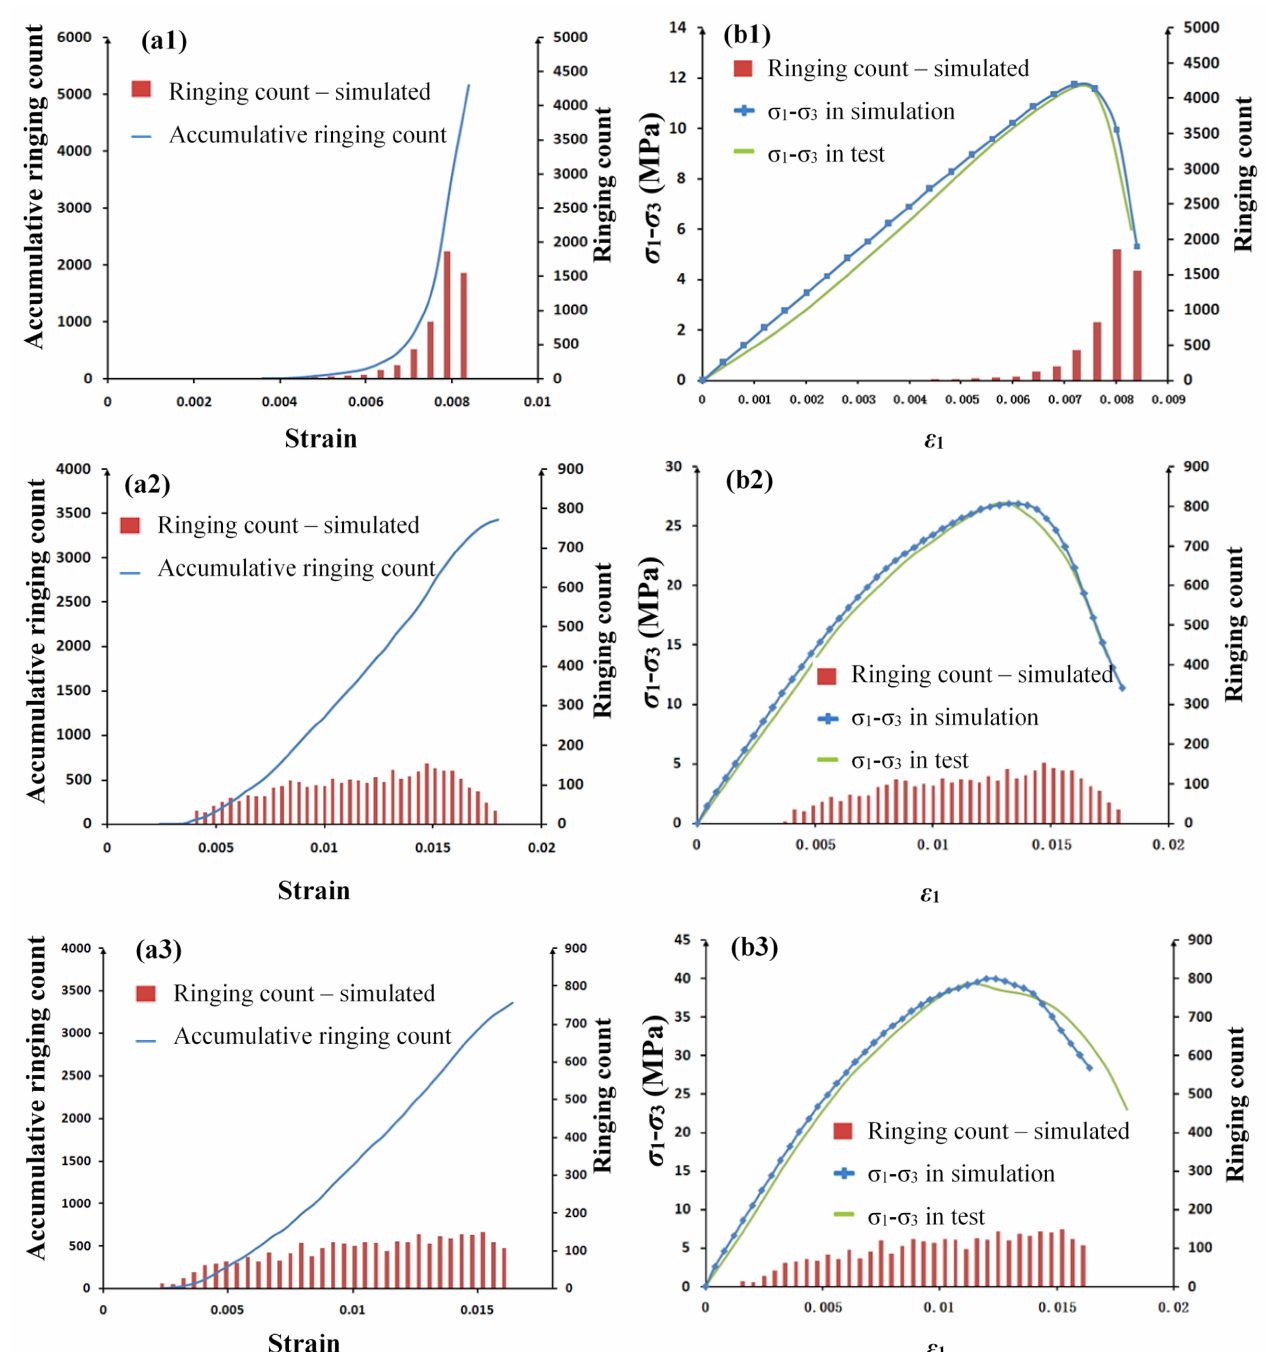
Figure 10. Damage characteristics and stress–strain relationships of red-bed soft rock in conventional triaxial compression numerical tests under different confining pressures (the confining pressure in ( a1 , b1 ) is 0, in ( a2 , b2 ) is 1 MPa, and in ( a3 , b3 ) is 3